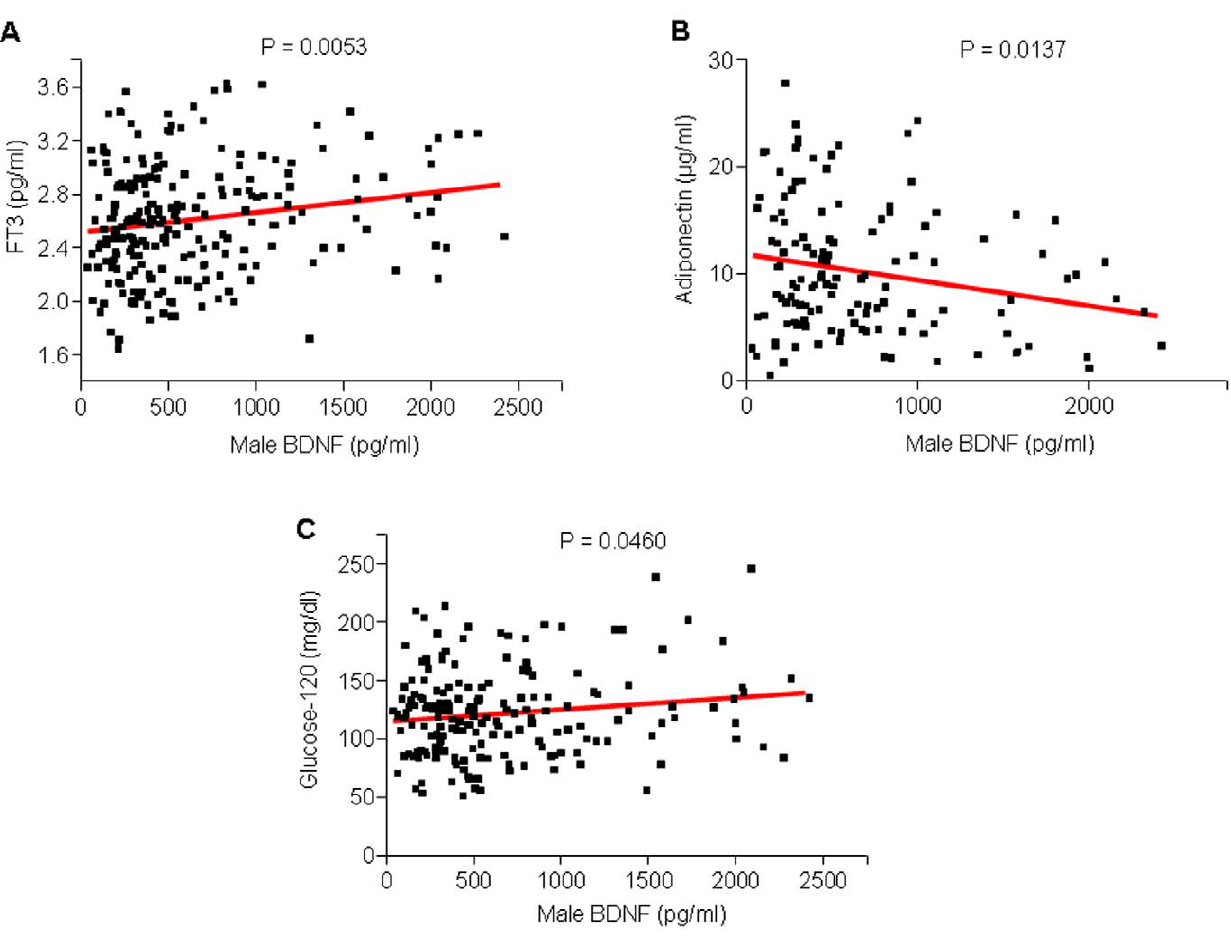
Figure 5. Linear regression analysis correlating plasma BDNF with thyroid function, adiponectin levels and glucose sensitivity in males. A and C. Plasma BDNF was positively correlated with FT3 (p=0.0053, R 2 =0.03348) and glucose-120 (p=0.0460, R 2 =0.02170). B. Plasma BDNF was inversely correlated with plasma adiponectin (p=0.0137, R 2 =0.04650).